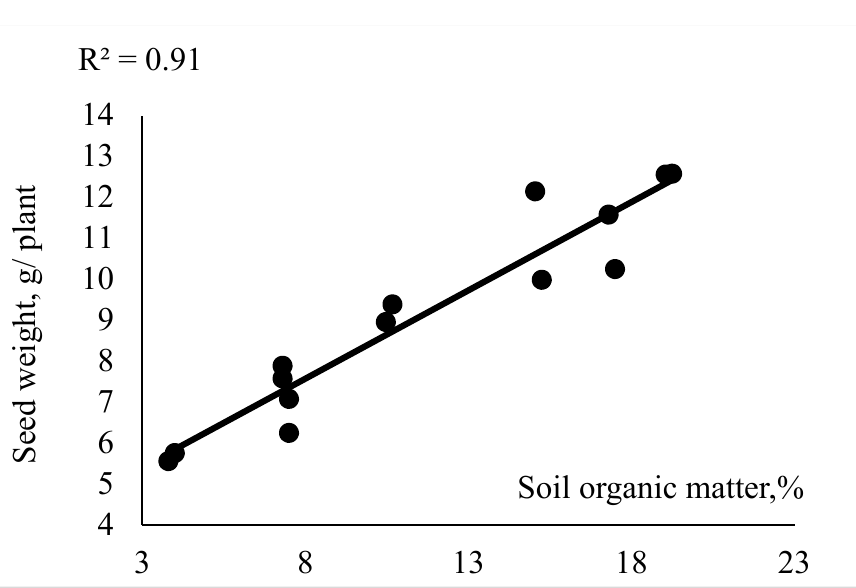
Figure 6. Relationship between MBC and seed weight of canola.